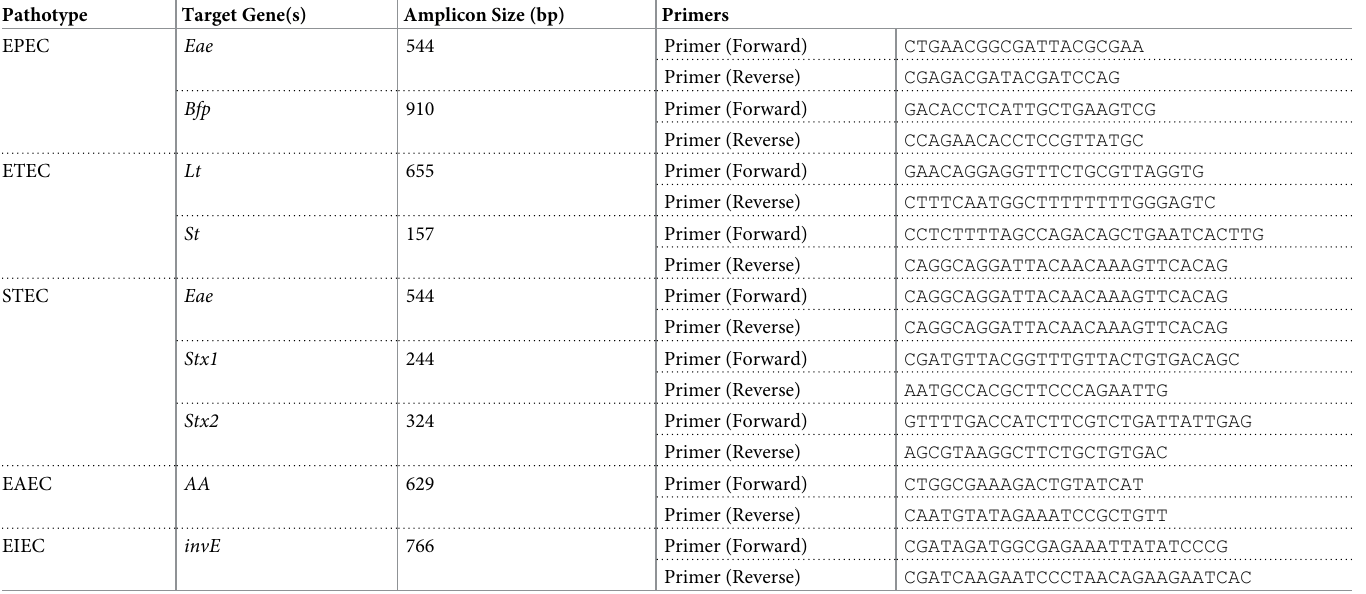
Table 1. Target genes and their characteristics for isolation of different pathotypes. Pathotype